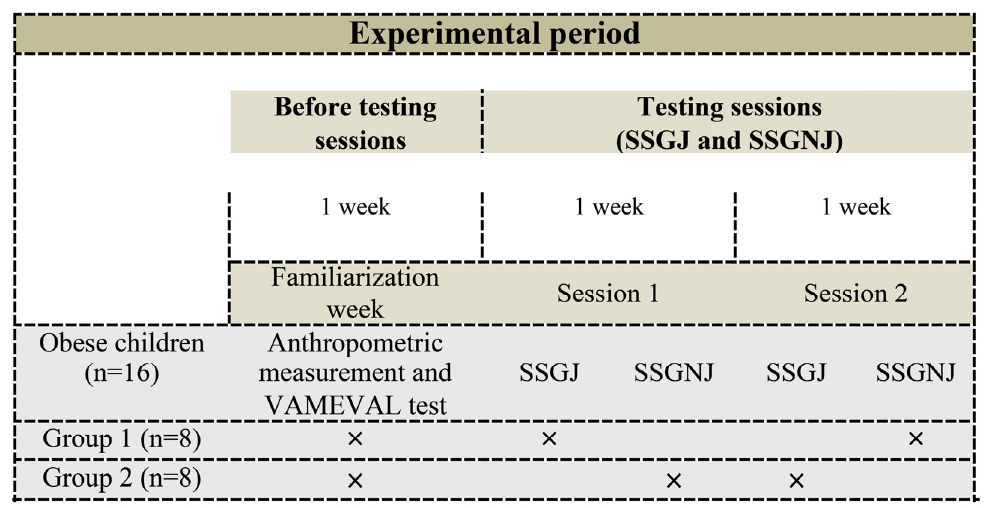
Figure 1. Representative diagram of the experimental protocol. SSG-J, SSG with joker; SSG-NJ, SSG without joker.